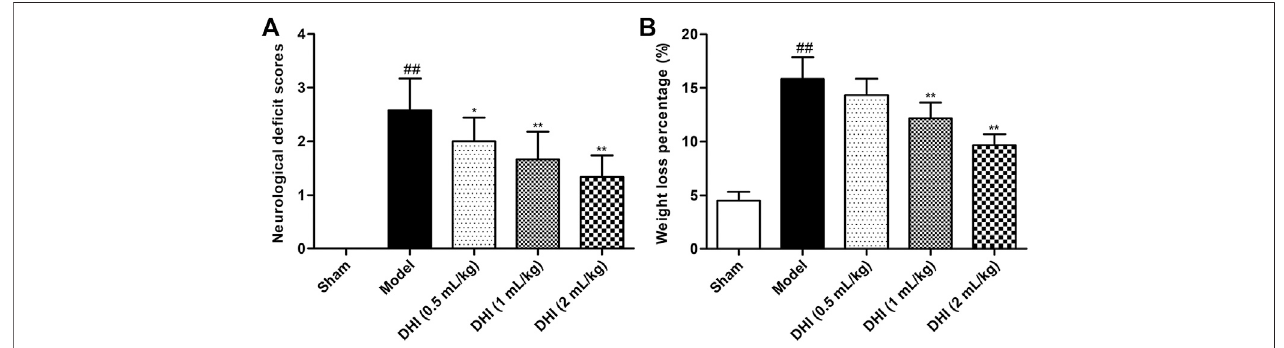
FIGURE1| EffectsofDHIonneurologicalde fi citscoresandweightlosspercentageinCIRIrats. (A) Thescoresoftheneurologicalde fi citinallgroups. (B) Thebody weight change of rats in all groups. Mean ± SD ( n (cid:2) 6). Asterisks denote the signi fi cant levels: ## P < 0.01 vs. sham group and * P < 0.05 and ** P < 0.01 vs. model group.